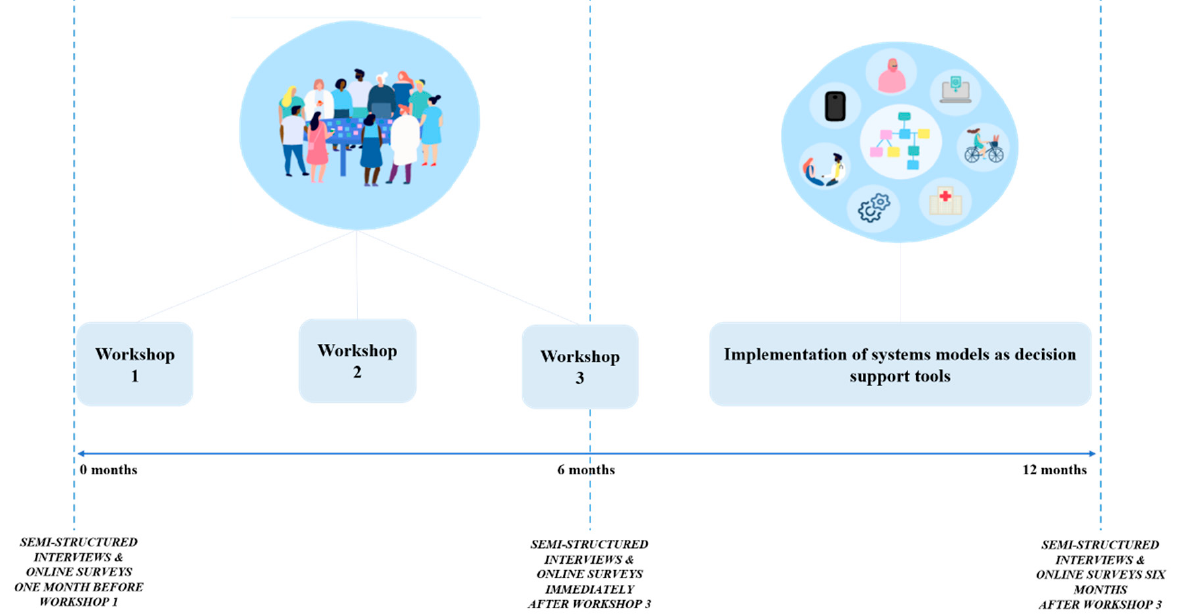
Figure 1. Evaluation time points aligned to the three PSM workshops. Evaluation will be conducted in two sites per year from 2022 to 2025 (total of eight sites).